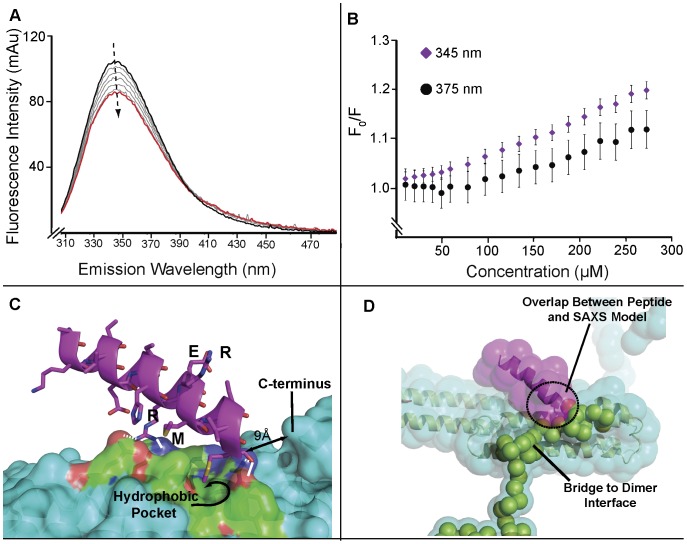
Interaction of RERMS peptides with eAPP.A) Emission spectra from the titration of 0.64 µM eAPP230–624 with RERMS peptides from 0–270 µM (1∶0–1∶420 molar ratio) using the Shimadzu RF-530PC. The black line indicates the starting concentration and the red line indicates the final concentration. The arrow indicates the direction of shift of the fluorescence peak. B) Stern-Volmer plot for the intermolecular quenching of 0.64 µM eAPP230–624 by the RERMS peptide for the emission wavelengths: 345 nm (purple diamonds) and 375 nm (black circles) C) Model of APP319-335 peptide bound to the E2 domain of APP derived from a dimer of an E2 domain fragment (residues 299 to 490) observed in its crystal structure protein data base entry 1RW6 [25]. The major interactions between the peptide and the protein are two hydrogen bonds involving Arg 328 and both polar and hydrophobic interactions between Met 335 and the hydrophobic pocket. The rim of the hydrophobic pocket into which Met 335 binds is 9 Å from the C-terminus of the E2 domain fragment. D) Superposition of the peptide model (pink) with the SAXS model. The green balls show the predicted path in the SAXS model of the chain that forms a bridge from the terminus of the E2 domain to the dimer interface containing the C-terminus of eAPP230–624. The overlap of the surfaces shows the overlap between the peptide docked into its binding site and the predicted path of the eAPP230–624 residues indicating that the two models are incompatible. This overlap suggests a mechanism by which binding of an RERMS peptide in the binding site predicted by the crystal structure could influence the stability of the dimer of eAPP230–624.